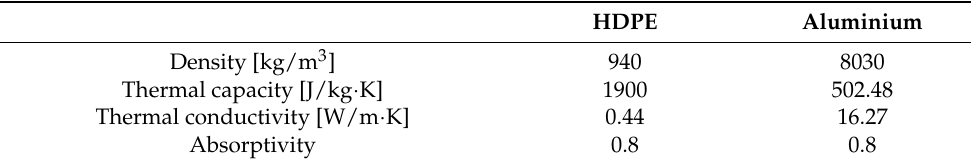
Table 4. Materials’ specifications.